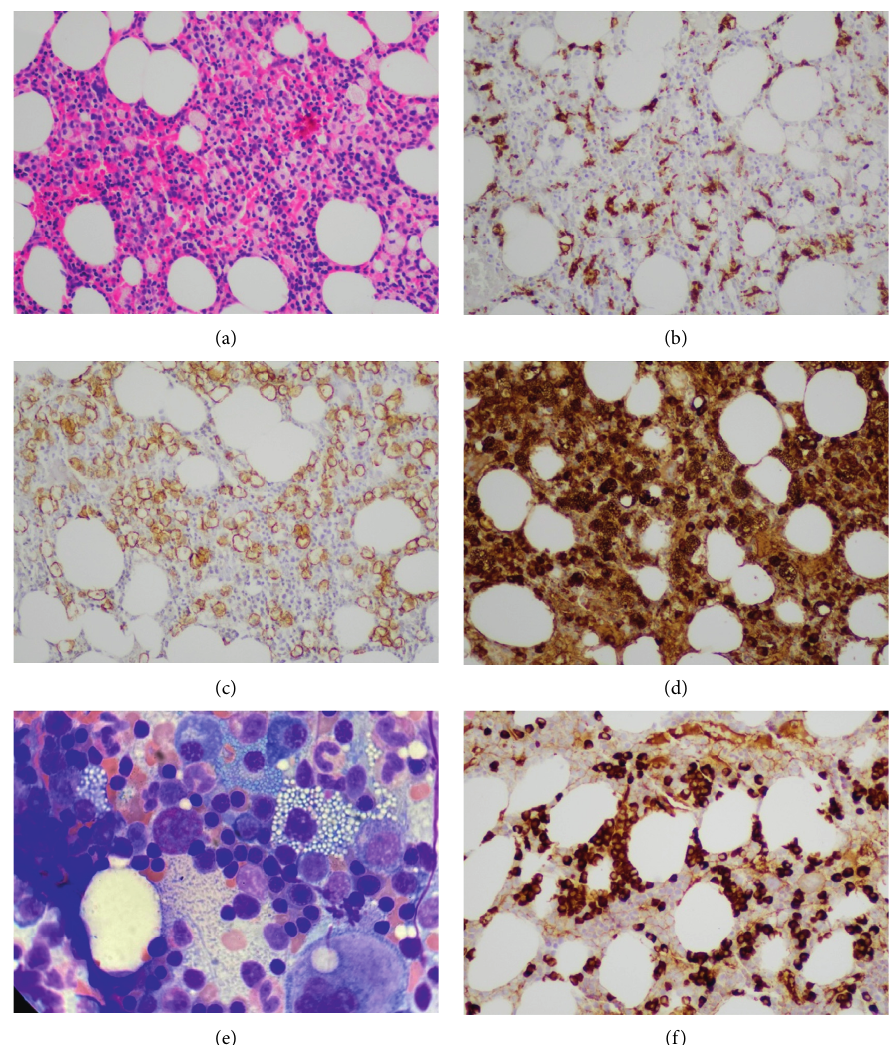
Figure 1: Bone marrow biopsy with foamy Mott cells on (a) H&E immunostain for (b) CD68 highlights scattered smaller cells of macrophage-monocyte lineage, but are negative in the larger foamy cells; however, they are positive for (c) CD138 and (d) kappa, confirming their plasmacytic differentiation. Note that the cytoplasmatic kappa IHC pattern matches the inclusions seen on H&E. (e) Bone marrow aspirate smear (Wright stain). (f) Posttherapy bone marrow biopsy, lambda light chain. Trephine biopsy cells original magnification 200x; aspirate smear (cell (E)) original magnification